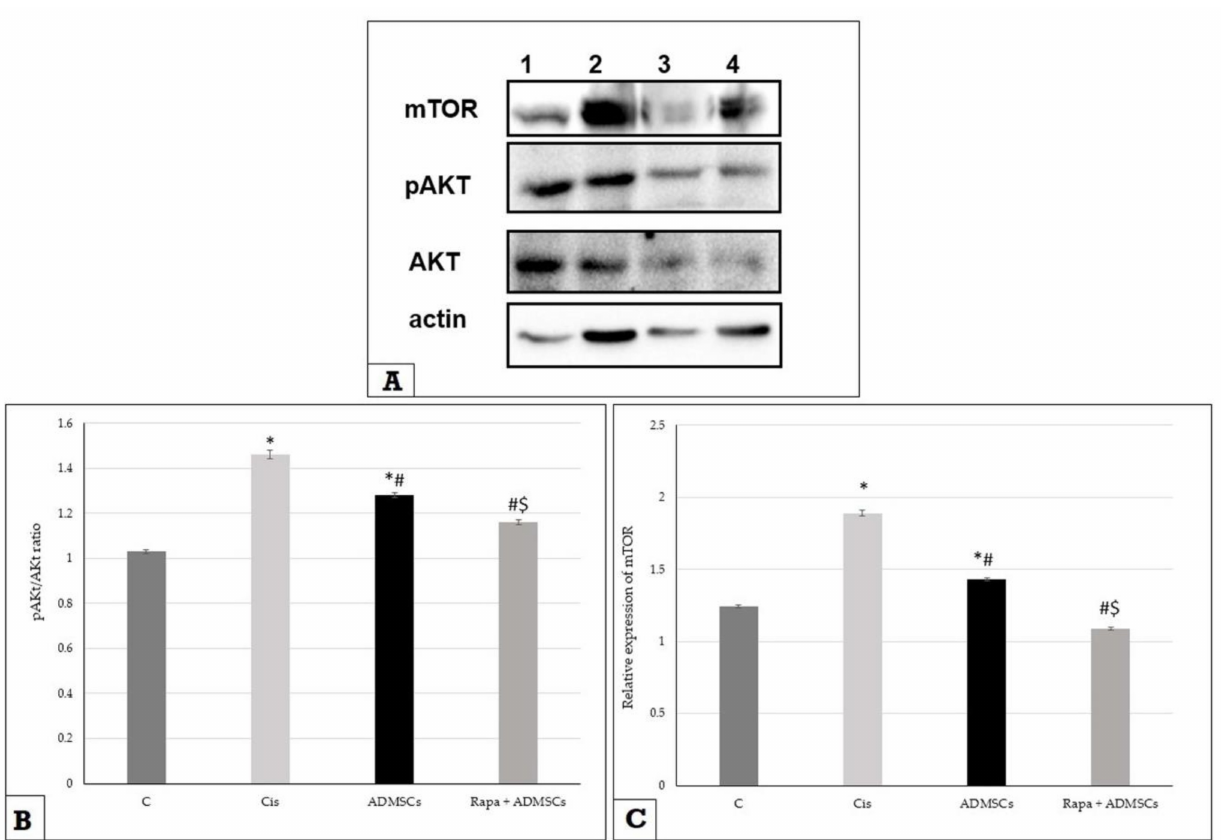
Figure 4. The impact of Rapa-ADMSC administration on Akt/pAkt and mTOR expressions at 10 days after cisplatin injection. ( A ) the products of western blotting of the tested genes, lane 1 = control group, lane 2 = Cis group, lane 3 = Rapa + ADMSC group and lane 4 = ADMSC group, ( B ) pAkt/Akt ratio and ( C ) mTOR expression in different studied groups. * Significant vs. control, # significant vs. Cis group and $ significant vs. ADMSC group.